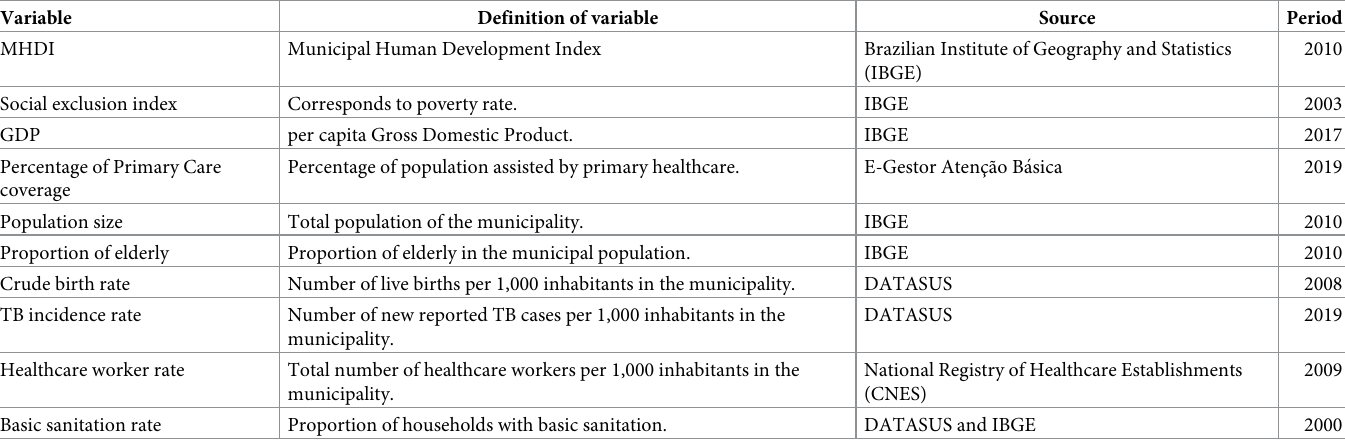
Table 1. Specification of socioeconomic and demographic variables. Variable